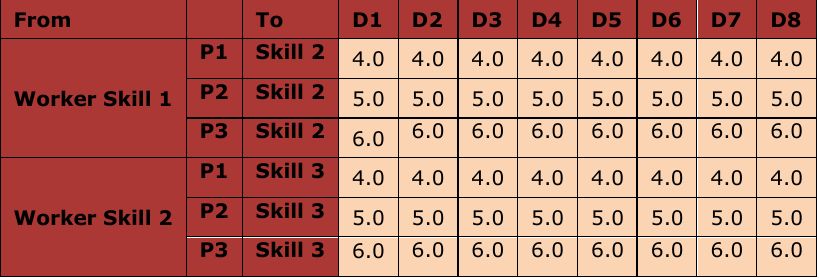
Table 5. Training Costs in Each Period